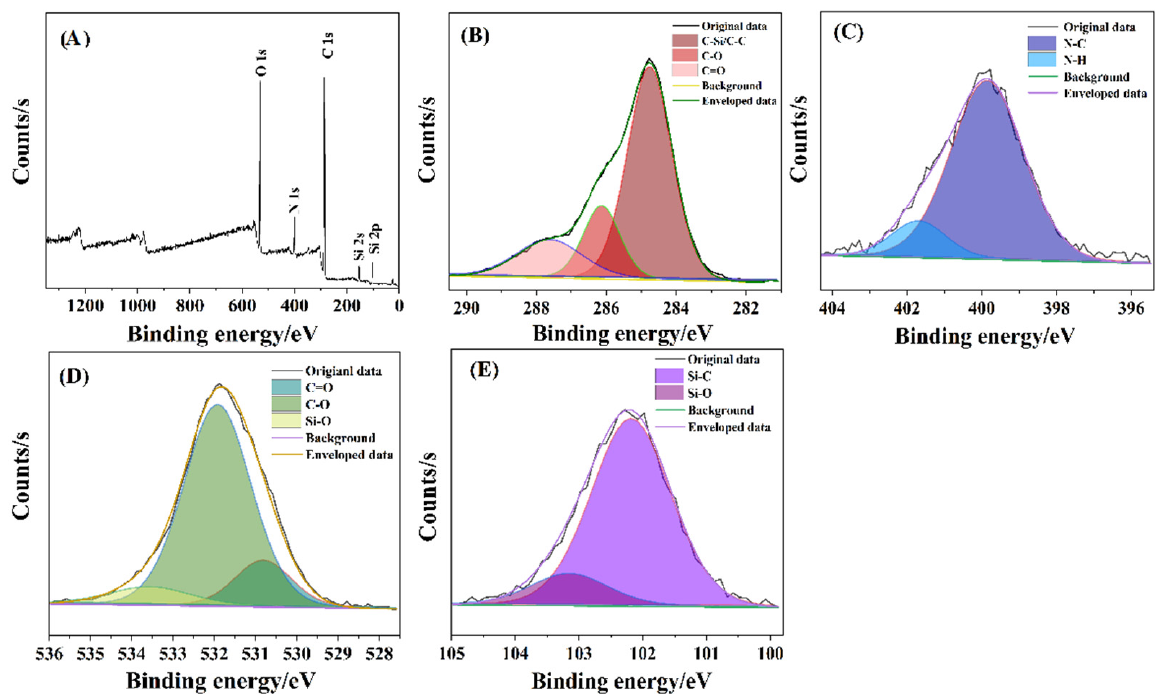
Figure 2. XPS profiles of SiNPs: ( A ) Survey; ( B ) C 1s; ( C ) N 1s; ( D ) O 1s; ( E ) Si 2p.